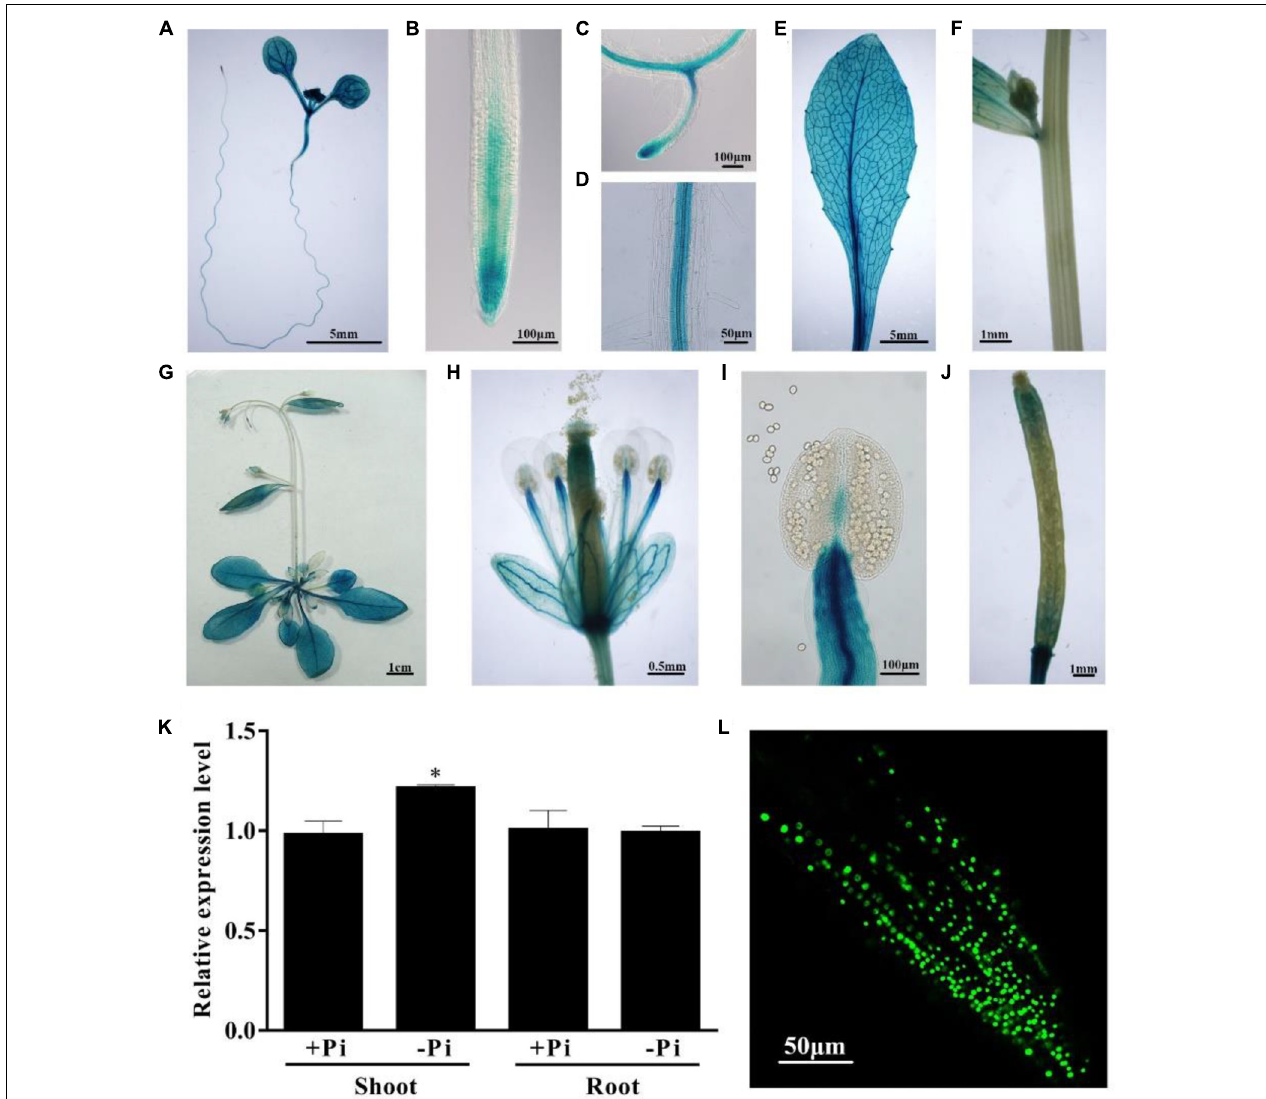
FIGURE 2 | Expression patterns of the PHL4 gene. (A–J) Tissue-specific expression patterns of PHL4::GUS . (A) An 8-day-old seedling; (B) a root tip; (C) a newly formed lateral root; (D) root mature zone; (E) a rosette leaf; (F) a stem; (G) a 25-day-old mature plant; (H) an open flower; (I) a stamen; (J) a silique. (K) Relative expression of the PHL4 gene in shoots and roots of 8-day-old WT seedlings under +Pi and –Pi conditions as determined by qPCR. Values are the means ± SD of three biological replicates and represent fold changes normalized to transcript levels of the WT on +Pi medium. Means with an asterisk are significantly different from the WT ( P < 0.05, t -test). (L) The subcellular localization of the GFP-PHL4 protein in the root tip of a 7-day-old seedling.